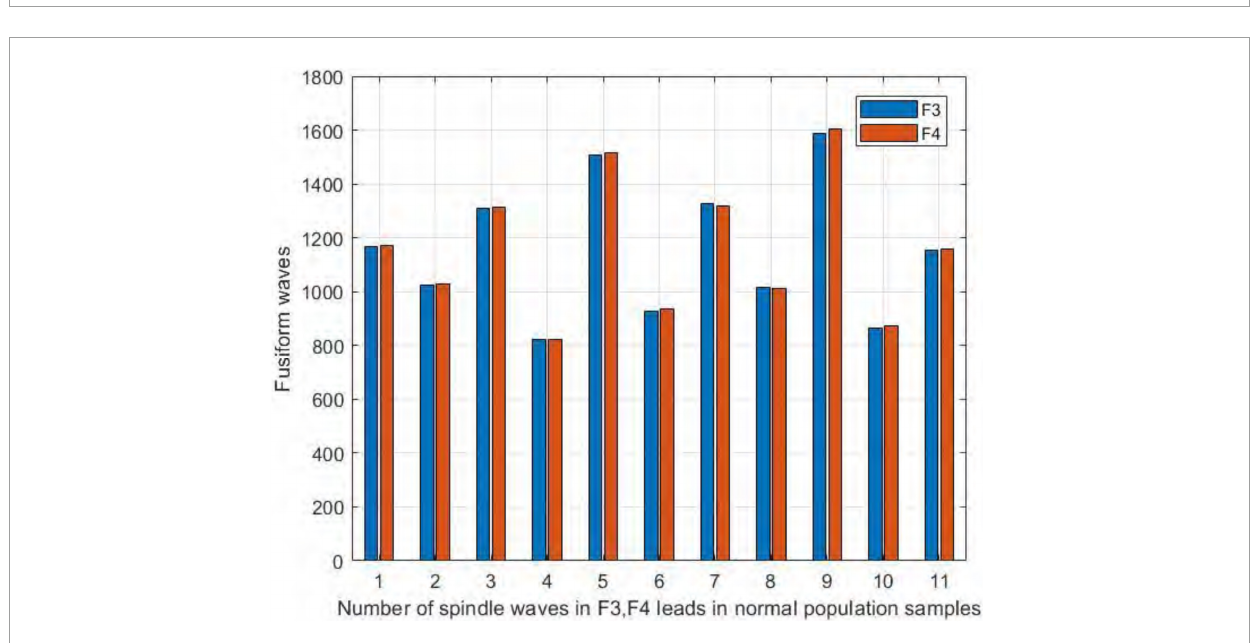
FIGURE13 Comparison of the number of spindles in channels F3 and F4 in normal